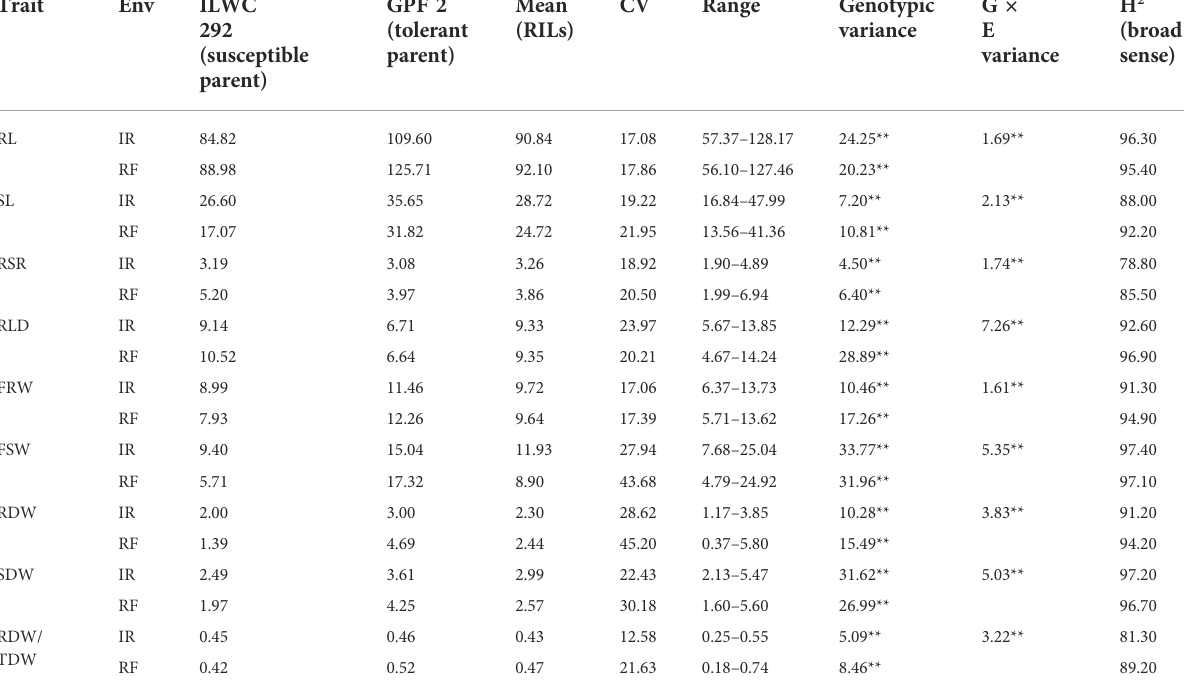
TABLE 2 Mean performance of chickpea RIL population for root-related traits under irrigated (IR) and rainfed (RF) conditions. Trait